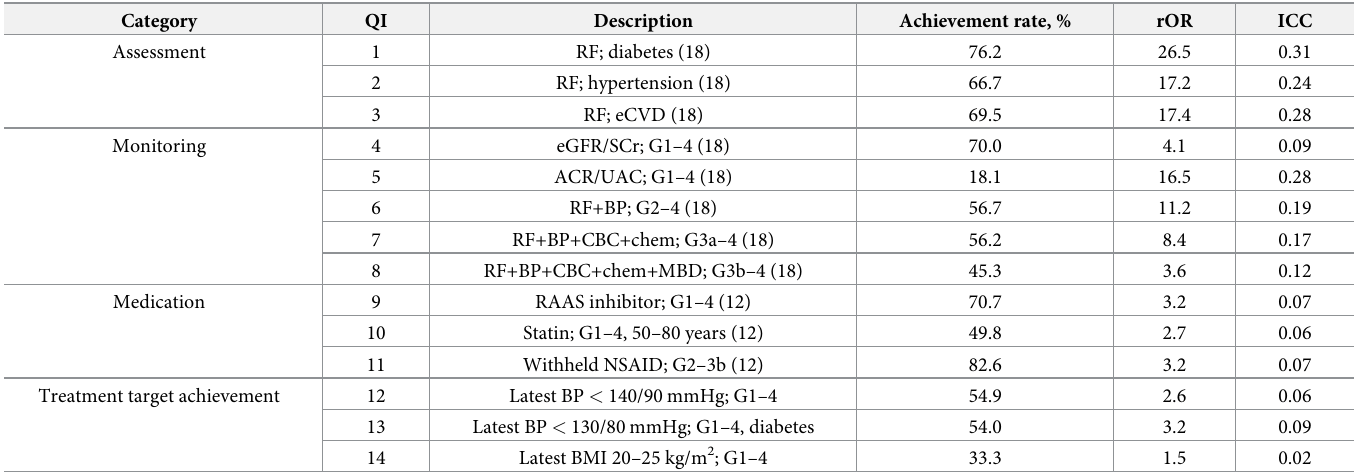
Range odds ratios (rOR) and intraclass correlation coefficients (ICC) are determined from the regression models. The column “Description” gives a shorthand outline of the respective QI in the format “outcome; denominator population (follow-up period in months)” (see Table 1 for detailed descriptions). Note that the denominator populations for the category Assessment encompass all patients with the respective predisposing condition, not only those affected by chronic kidney disease. Abbreviations: ACR, albumin-to-creatinine ratio; BMI, body mass index; BP, blood pressure; CBC, complete blood count; chem, blood chemistry (at least one of urea, sodium, potassium); eCVD, established cardiovascular disease; MBD, mineral and bone disorder screening; NSAID, non-steroidal anti-inflammatory drug; RAAS, renin-angiotensin-aldosterone system; renal function; SCr, serum creatinine; UAC urinary albumin